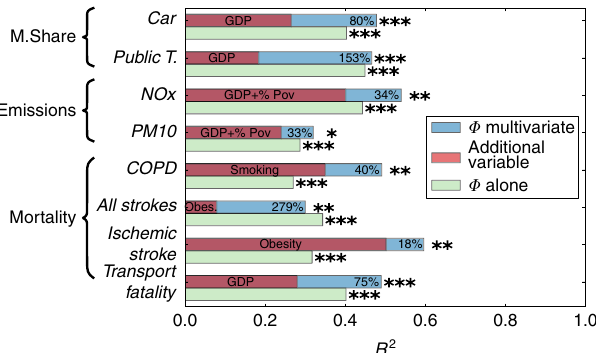
Fig. 6 Multivariate analysis of mobility share, emissions and mortality causes. The R 2 when only Φ is considered is shown in green. The contribution from at least one or two variables that explain an important part of the variance is shown in red, while in blue we display the additional gain in variance by introducing Φ . The extra variables are GDP (gross domestic product per capita), % Pov (percentage of poverty), smoking (prevalence of smoking in fraction of population) and obesity (prevalence in fraction of population). Data sources are listed in Supplementary Note 8 and the complete set of results for the multivariate analysis are shown